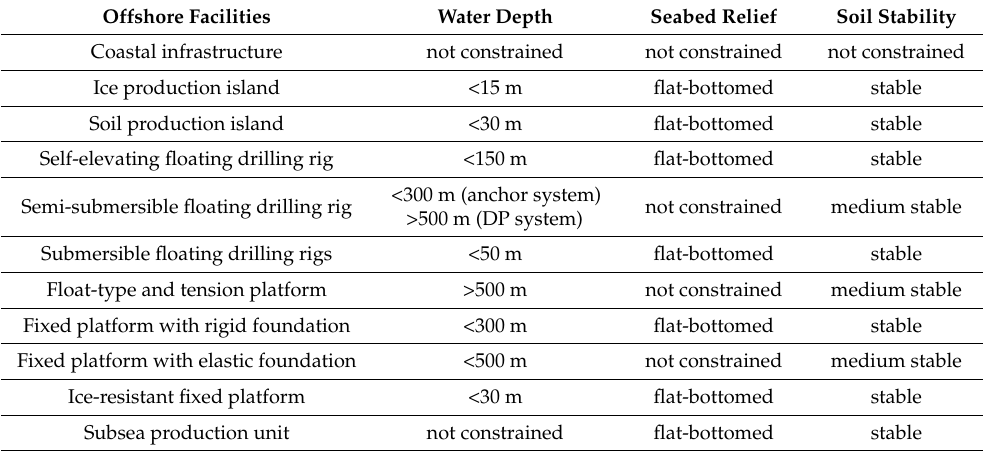
Table 3. The applicability analysis of offshore oil and gas facilities (engineering-geological factor) [8–11].